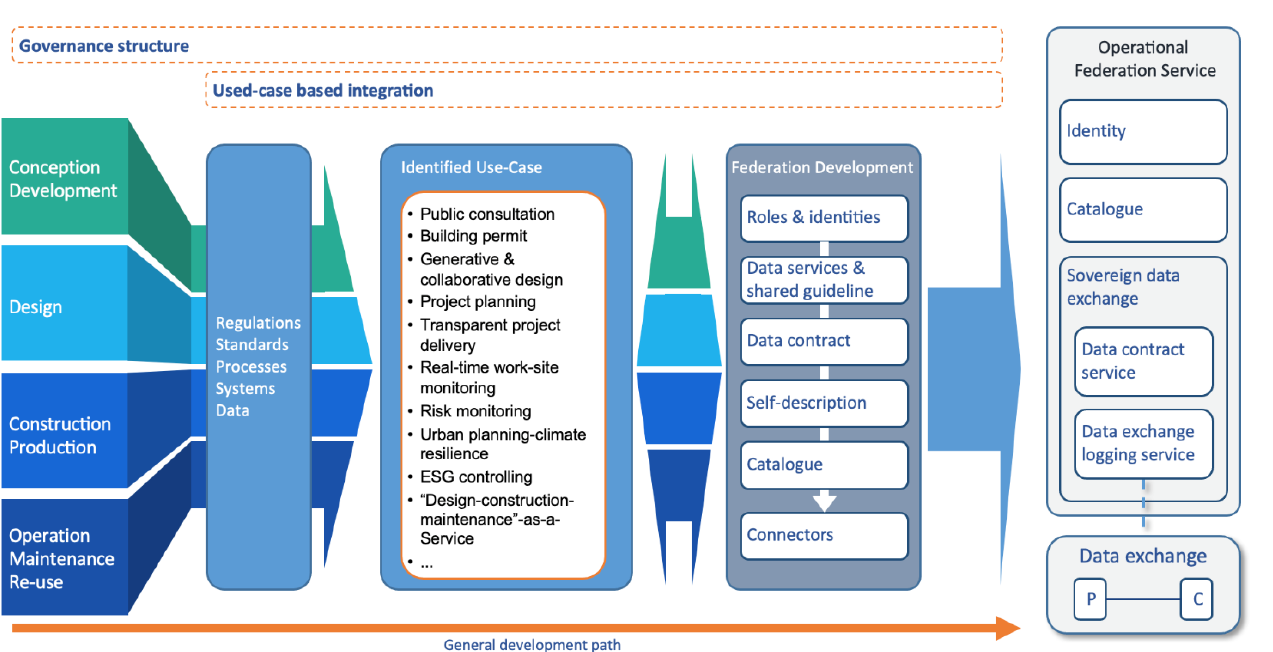
Figure 3. The Federated Innovation Platform prototype (WP3 and 4): A visual representation of the platform’s regulatory concept, user roles and interactions, and integration of in-house and third-party services, showing how data flows and interface requirements are formalized, and how hardware and cloud services are set up and configured according to the state of the art. Depicting also the software engineering principles for data management, federated platform functions and user interaction that are implemented in the platform (from authors’ own research and depiction of federated infrastructure platform concept [1,11] according to IDSA Reference Architecture model. Reprinted/adapted with permission from Ref. [27]).